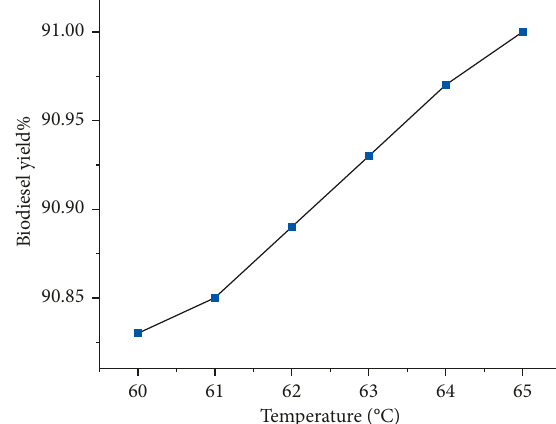
Figure 3: Biodiesel yield as a function of temperature variation.